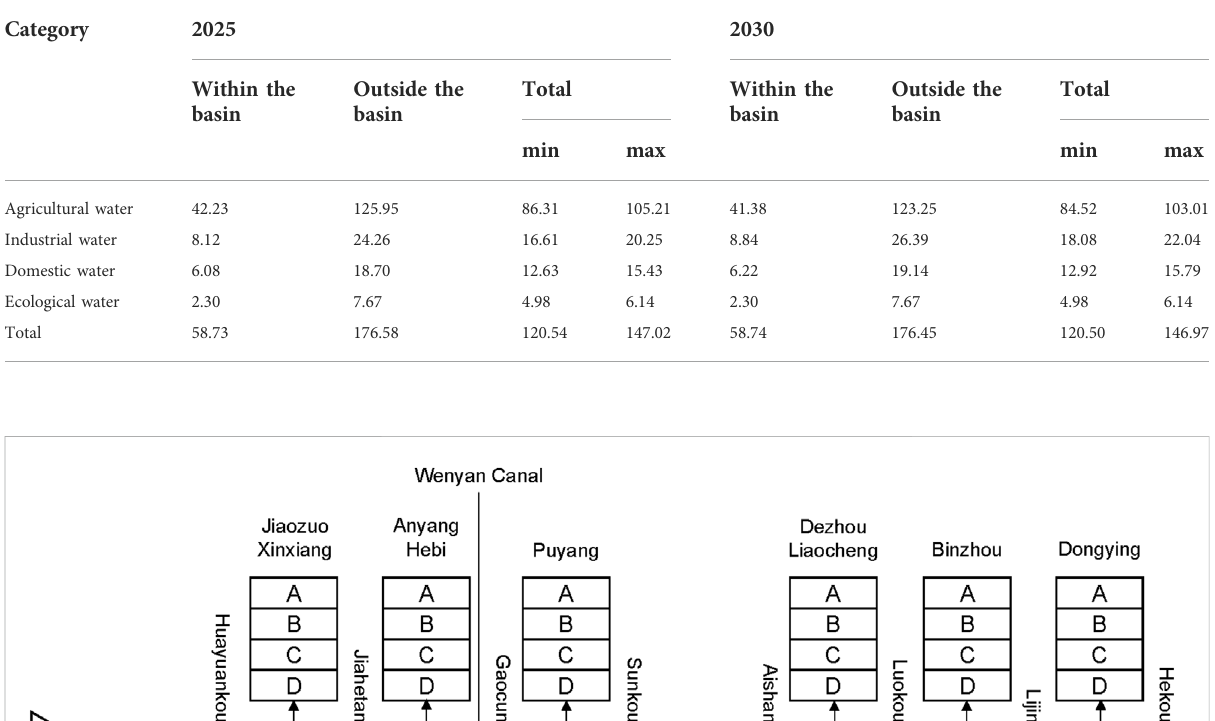
TABLE 3 Water demand by users in the lower Yellow River/10 8 m 3 (water use outside the basin is water diverted to the Huai River Basin and the Shandong Peninsula, details can be found in the cited article).